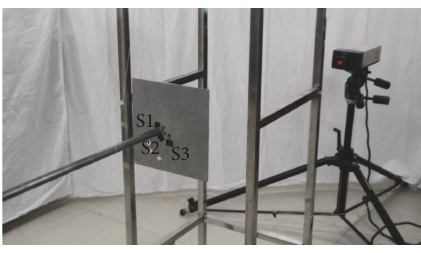
Figure 4: Experimental setup.